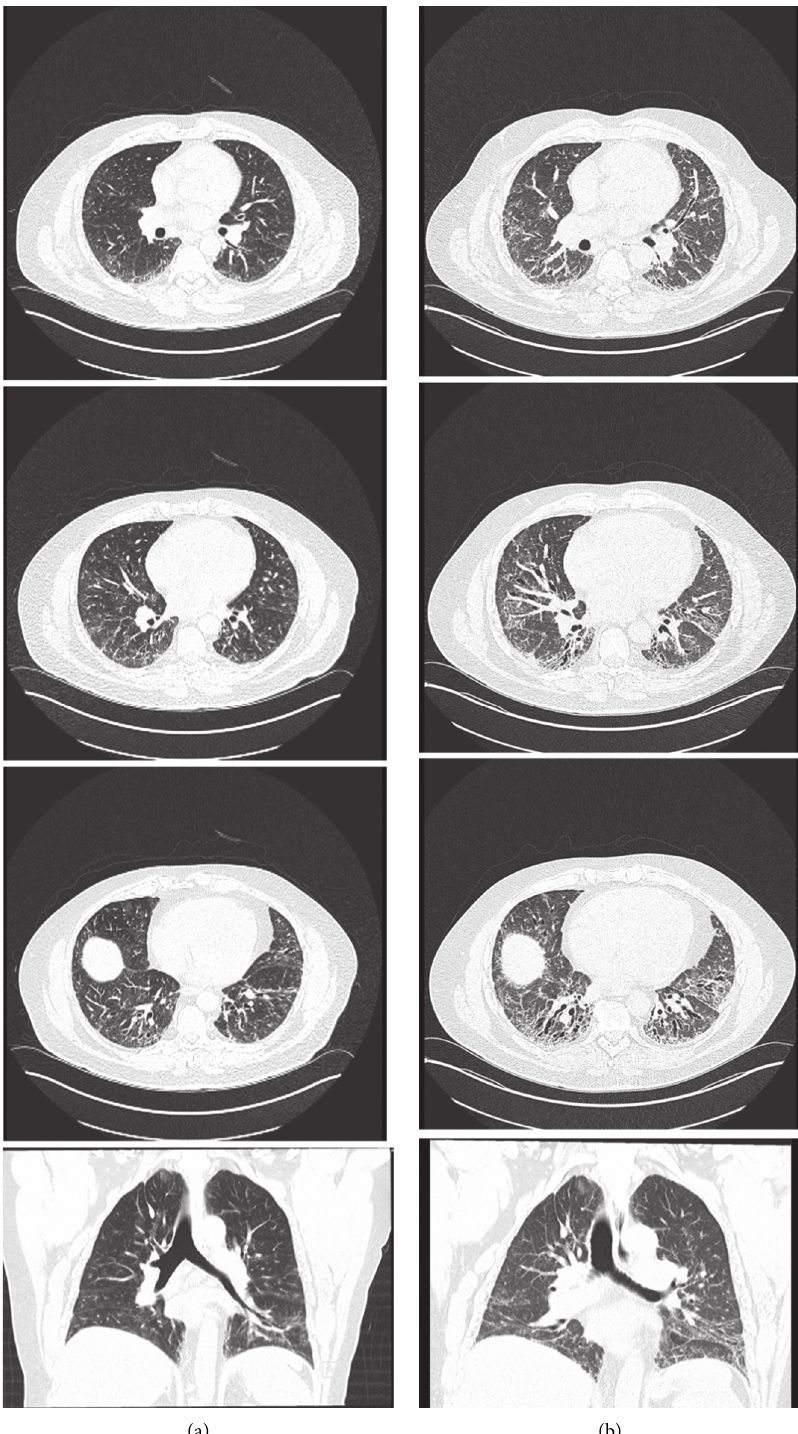
Figure 3: High-resolution computed tomography of the chest (Case 2). The scan 10 months prior to our evaluation (a) demonstrated a typical appearance of non-specific interstitial pneumonia (NSIP) with increased reticulation, traction bronchiectasis, lobar volume loss, and ground glass opacification in the lower lung zones. Bibasilar ground glass opacities that spare the subpleural region are characteristic for NSIP. The scan taken at our center 10 months later (b) demonstrated significant progression in fibrotic